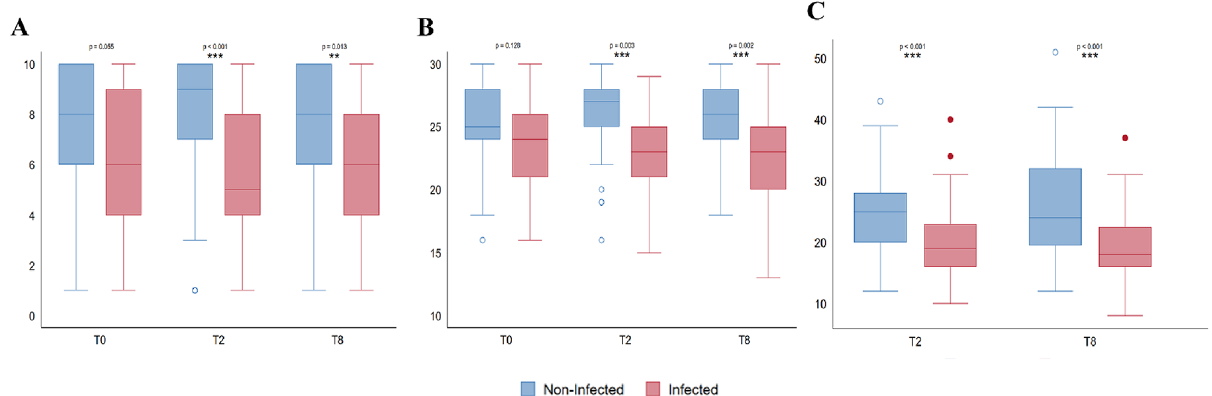
Figure 2. Cognitive ( A , B ) and executive performance ( C ) assessed by Clock Drawing Test ( A ), Mini-Mental State Examination ( B ) and WAIS-III ( C